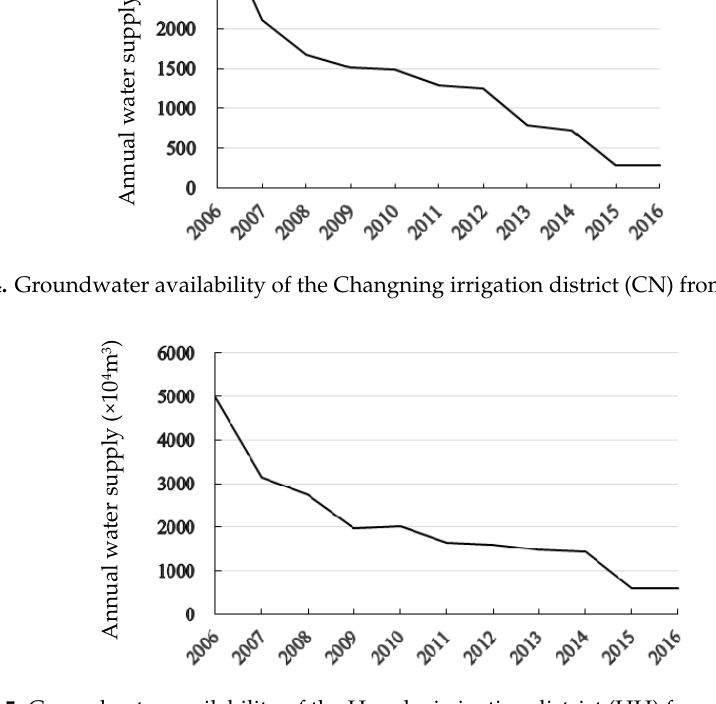
Figure 5. Groundwater availability of the Huanhe irrigation district (HH) from 2006 to 2016.